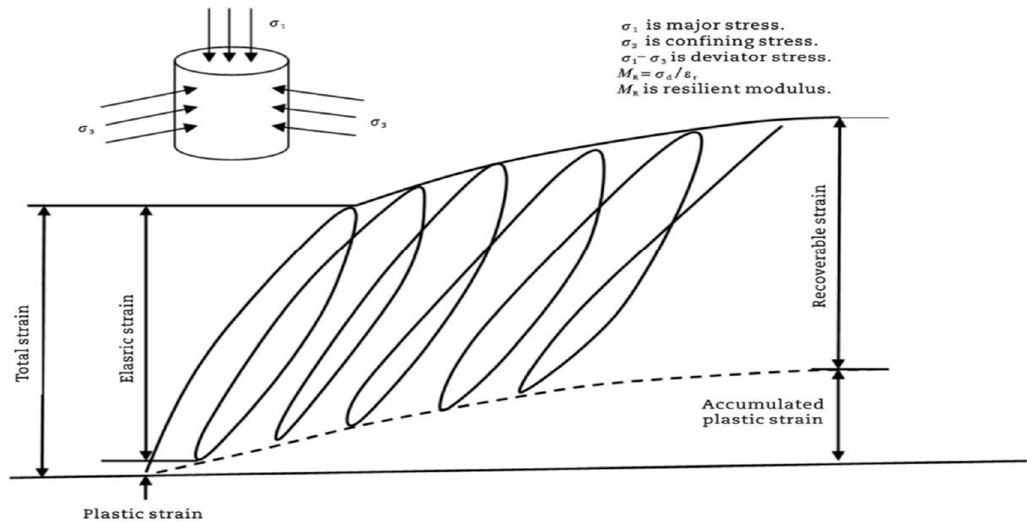
Figure 2. De fi nition of recoverable strain and soil resilient modulus